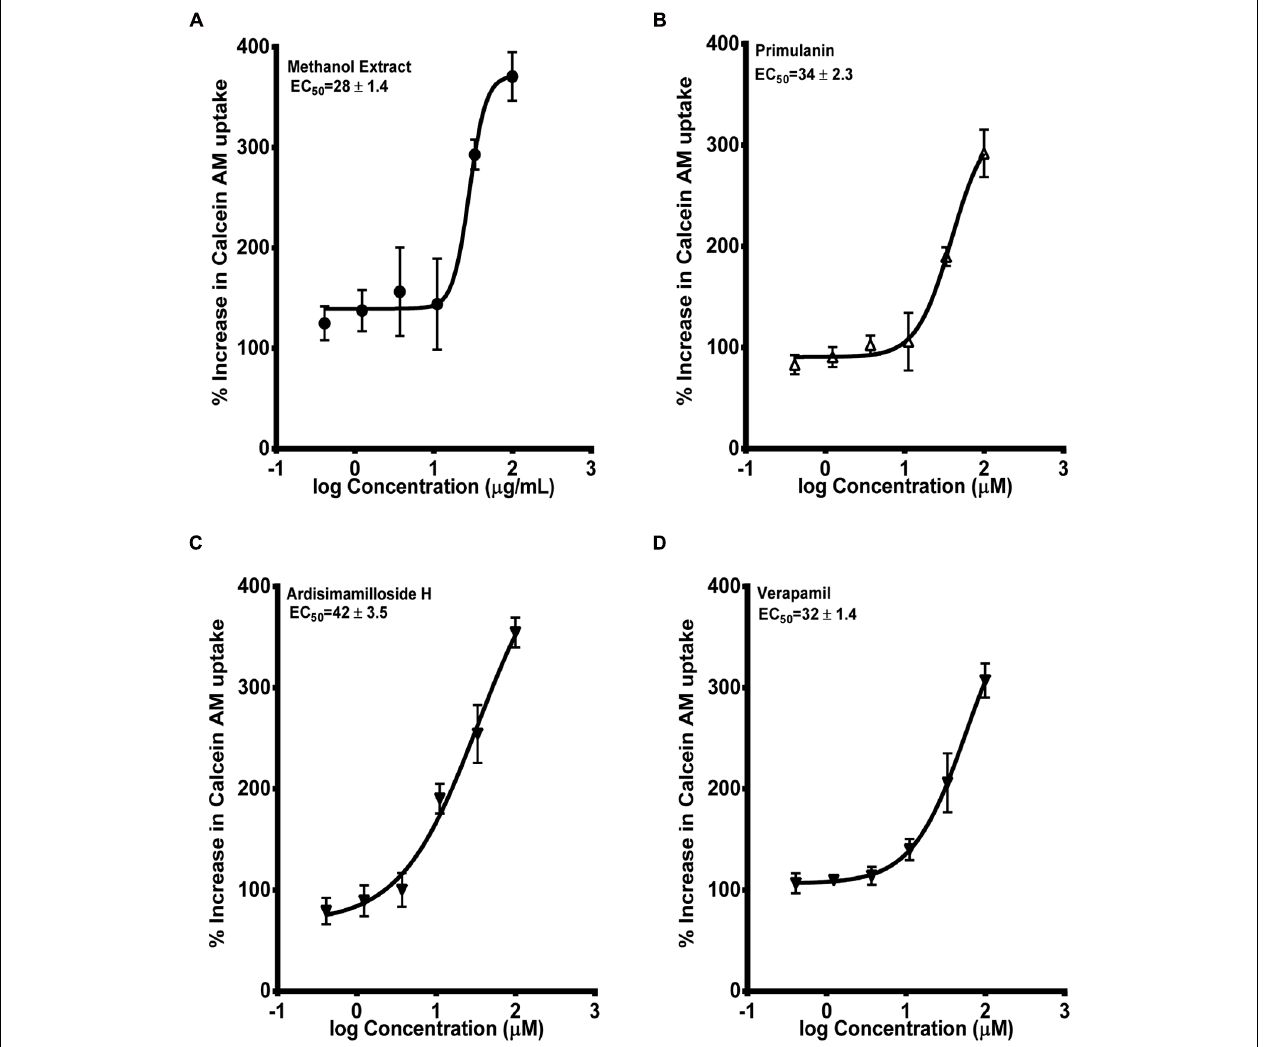
FIGURE 5 | Dose-response curves of P-gp inhibition by methanol extract of Labisia pumila roots (A), its two saponin constituents (B–C) and positive control verapamil (D), determined by calculating the percent uptake of calcein AM into hMDR1-MDCKII cells.